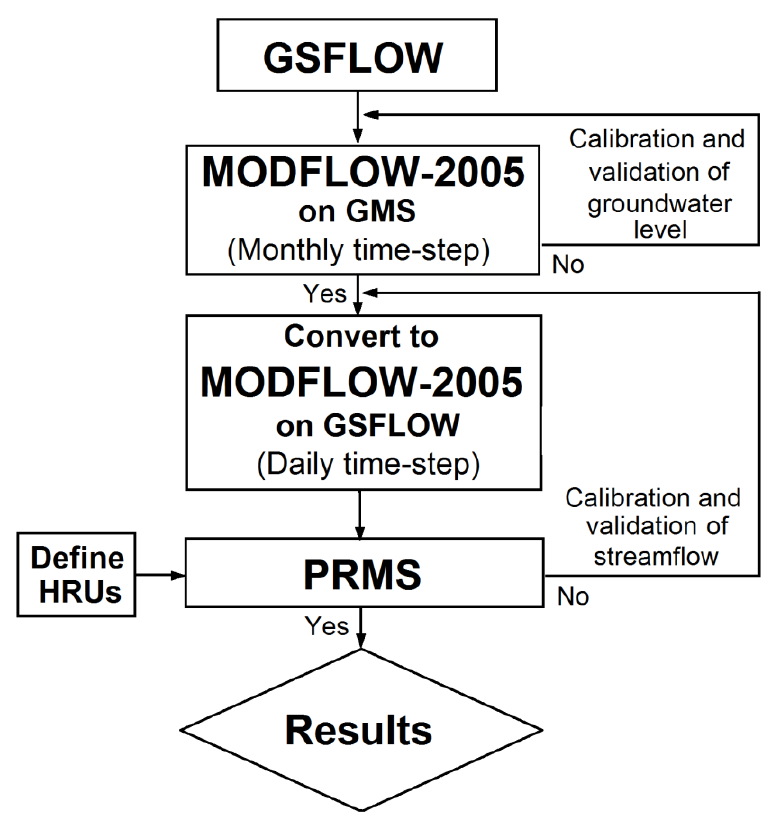
Figure 3. The calibration and validation workflow of the numerical model in the study.